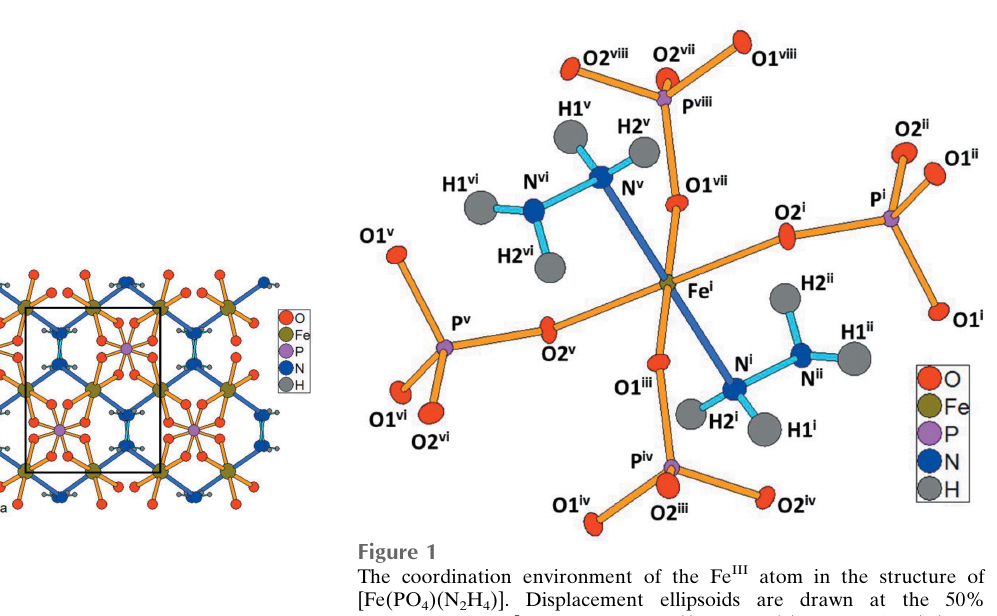
Figure 1 The coordination environment of the Fe III atom in the structure of [Fe(PO 4 )(N 2 H 4 )]. Displacement ellipsoids are drawn at the 50% probability level. [Symmetry codes: (i) x , y , z ; (ii) 0.5- x , 0.5- y ; (iii) (cid:3) x , y + 0.5, 0.5- z ; (iv) x + 0.5, (cid:3) y , 0.5- z ; (v) (cid:3) x , (cid:3) y , (cid:3) z ; (vi) x + 0.5, y + 0.5, (cid:3) z ; (vii) x , 0.5- y , z + 0.5; (viii) 0.5- x , y , z +